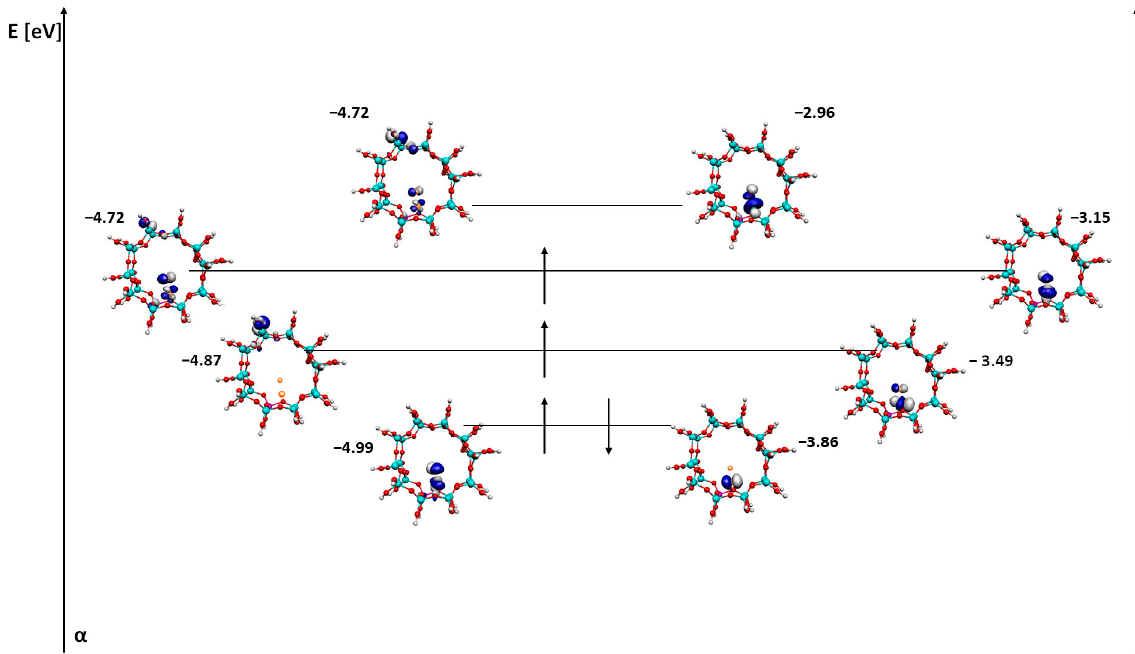
Figure 5. HOMO, SOMO and LUMO alpha and beta orbitals for ZSM-5 with FeO adsorbed next to the active site. the active